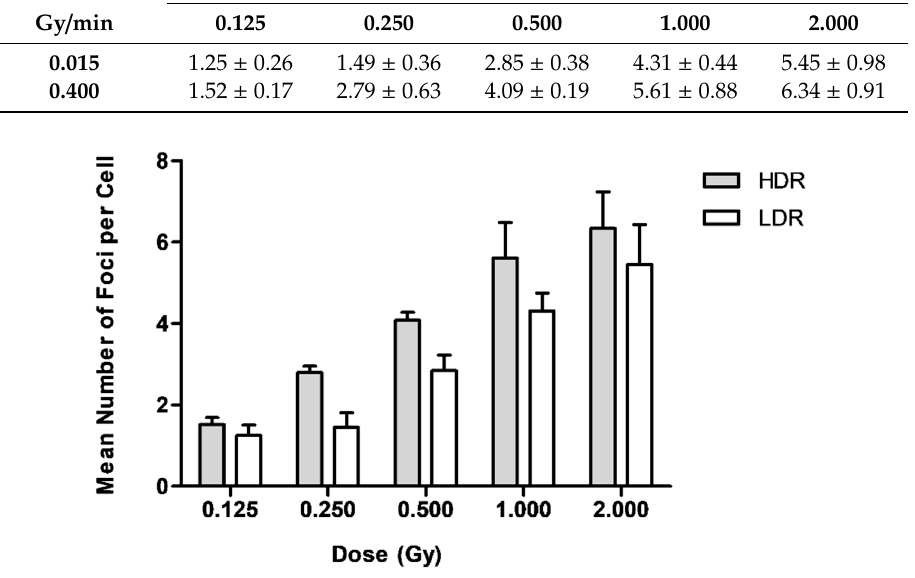
Table 1. Dose response data for γ -H2AX foci following exposure to high dose-rate (HDR; 0.400 Gy / min) and low dose-rate (LDR; 0.015 Gy / min) neutron radiation. All values represent the mean obtained for four di ff erent donors. The error bars are the standard deviations representing the interindividual variation among the four donors. Table 2. Ratio of the mean number of foci measured at different dose points (HDR/LDR).